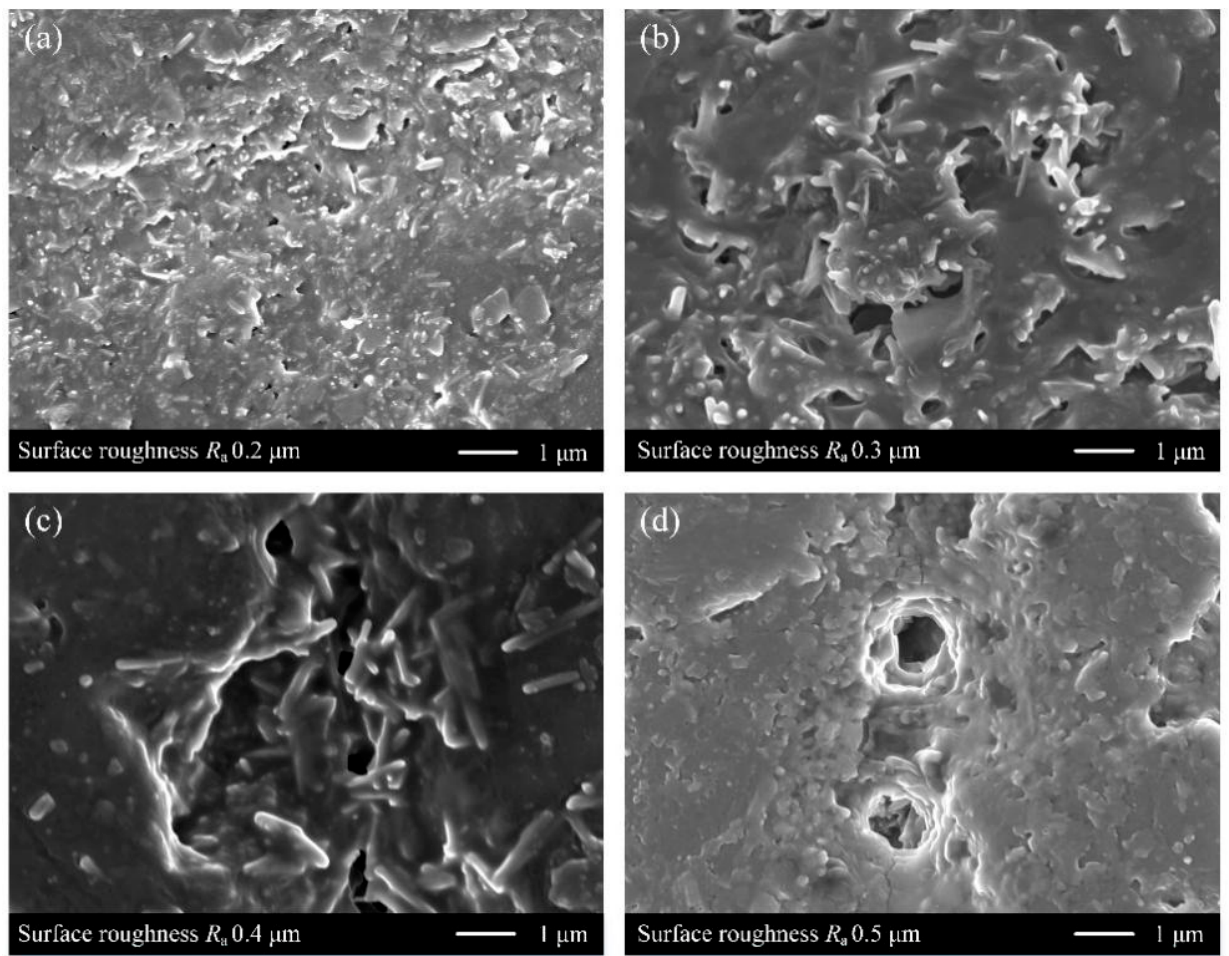
Figure 8. Micropore structure with different surface roughness: ( a ) R a = 0.2 μ m; ( b ) R a = 0.3 μ m; ( c ) R a = 0.4 μ m; ( d ) R a = 0.5 μ m.